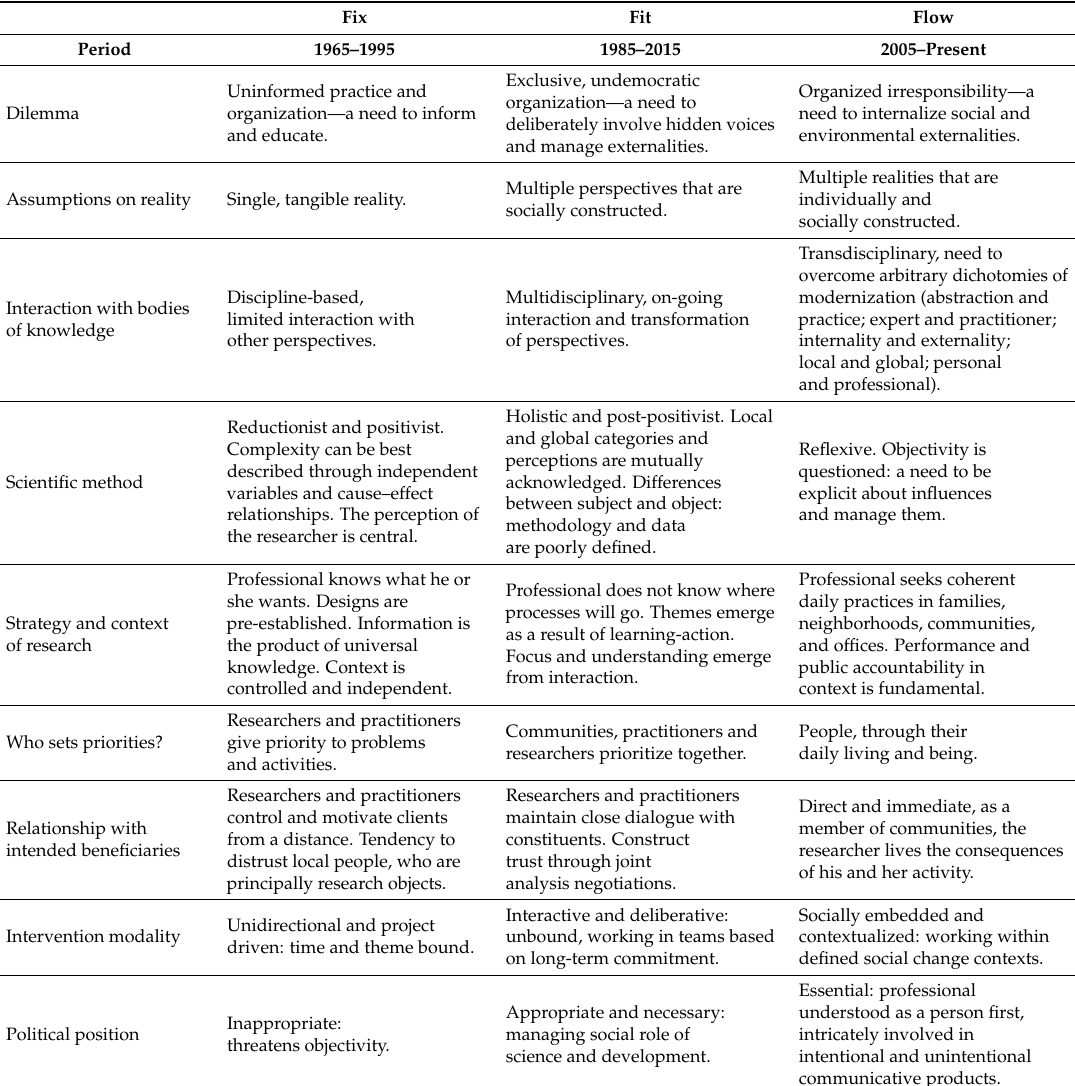
Table 1. Contrasting periods of development practice in Ecuador: fix (information provision), fit (process facilitation), and flow (being and